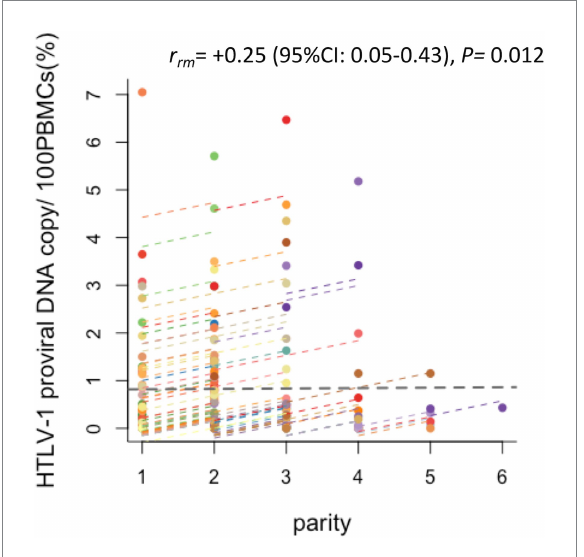
FIGURE 4 Changes in the HTLV-1 PVL of HTLV-1-positive pregnant women by parity. Plots of the correlation between the HTLV-1 PVL and parity of HTLV-1-positive pregnant women. Of the study participants, the 87 who were HTLV-1 seropositive and had their PVL measured more than twice were analyzed by repeated measures correlation (rmcorr). Each colored plot line shows the chronological change in HTLV-1 PVL of an individual HTLV-1- carrier pregnant woman. Positive correlations were found between increased HTLV-1 PVL and increased parity ( r = 0.25, p = 0.012, 95% CI 0.05,